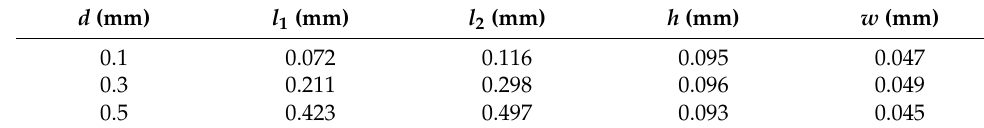
Figure 5. Surface morphology of TC4 alloy after laser micro-texturing: ( a ) d = 0.1 mm; ( b ) d = 0.3 mm; ( c ) d = 0.5 mm